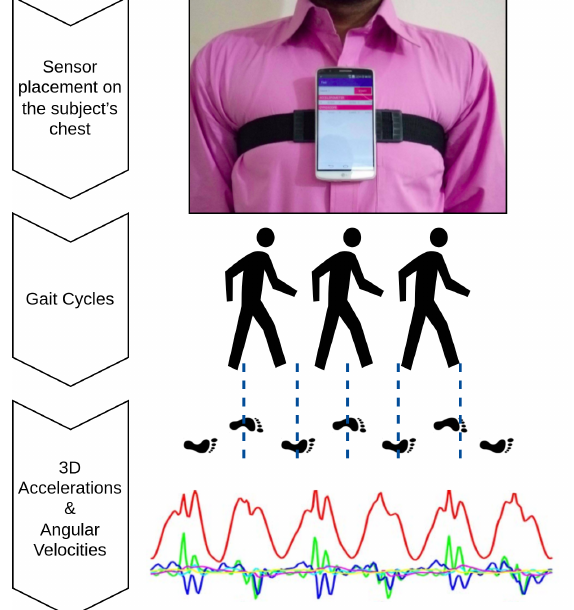
Figure 2. Data Collection: The inertial gait data were collected in one of our previous studies [19] using a chest-mounted smartphone having an on-board tri-axial accelerometer and a tri-axial gyro- scope. An autobiographical memories paradigm was employed, where the subjects were asked to recall a past relevant emotional event before the start of each trial.